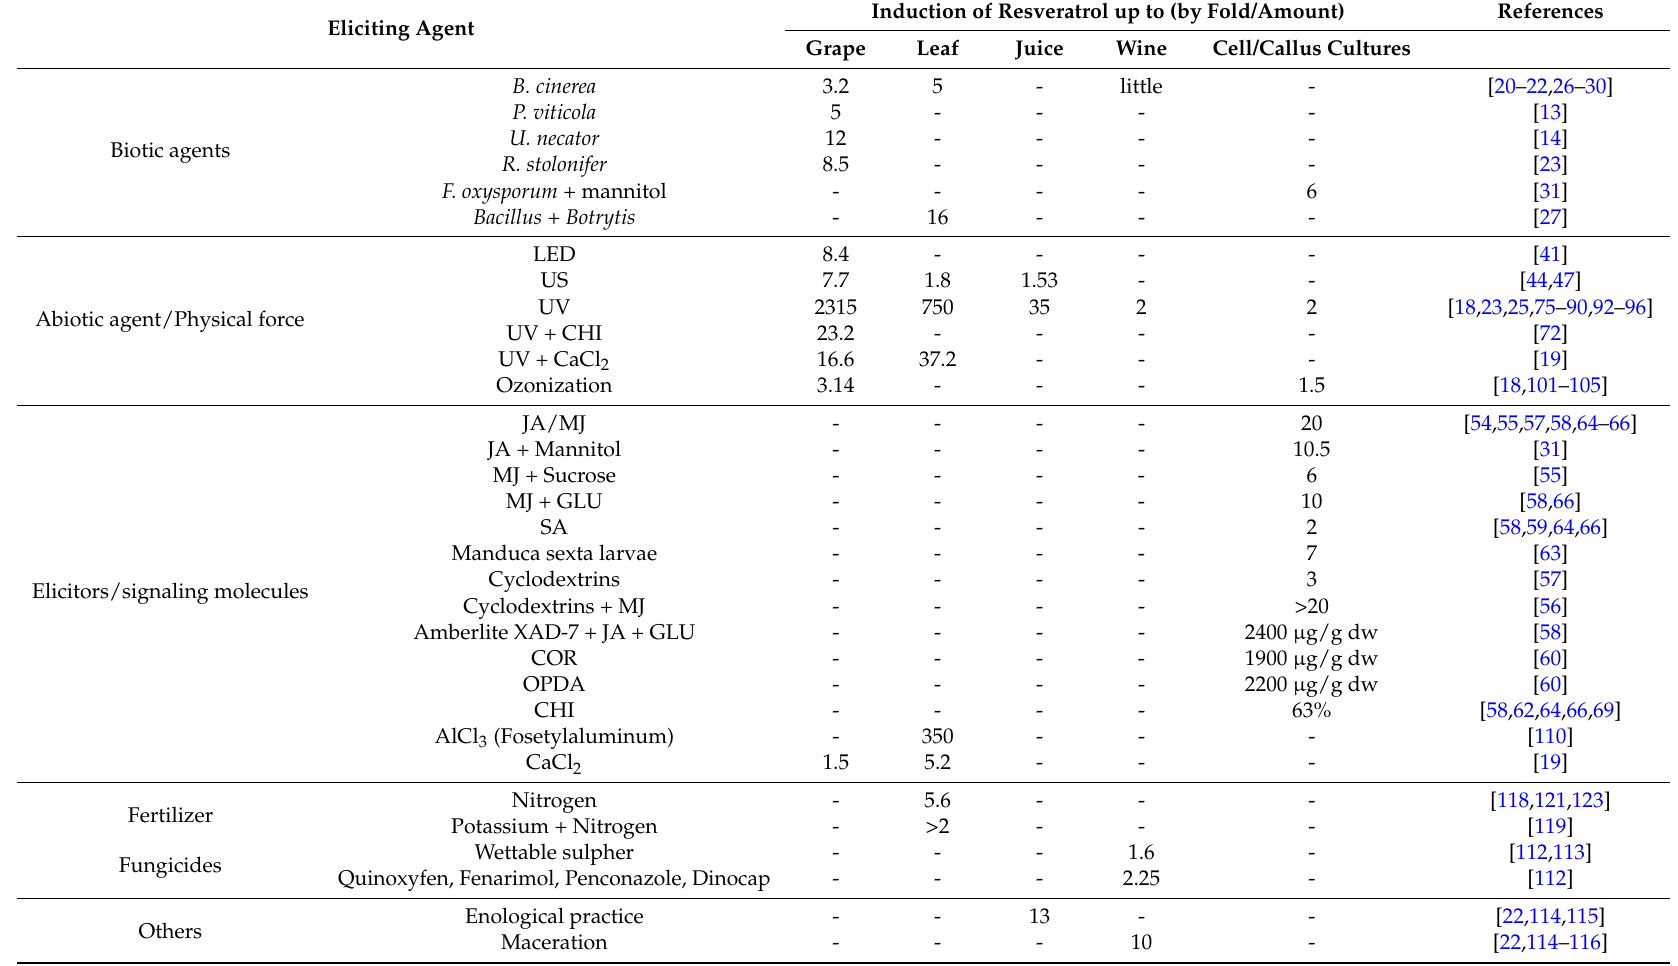
Table 1. Induced amount of resveratrol in grape skin, leaves, juice, wine, and cell/callus cultures by different external stimuli. Eliciting